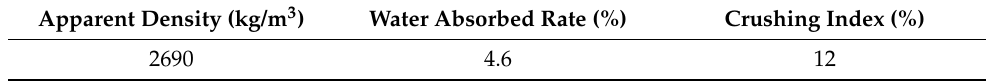
Table 1. The basic properties of recycled aggregate.